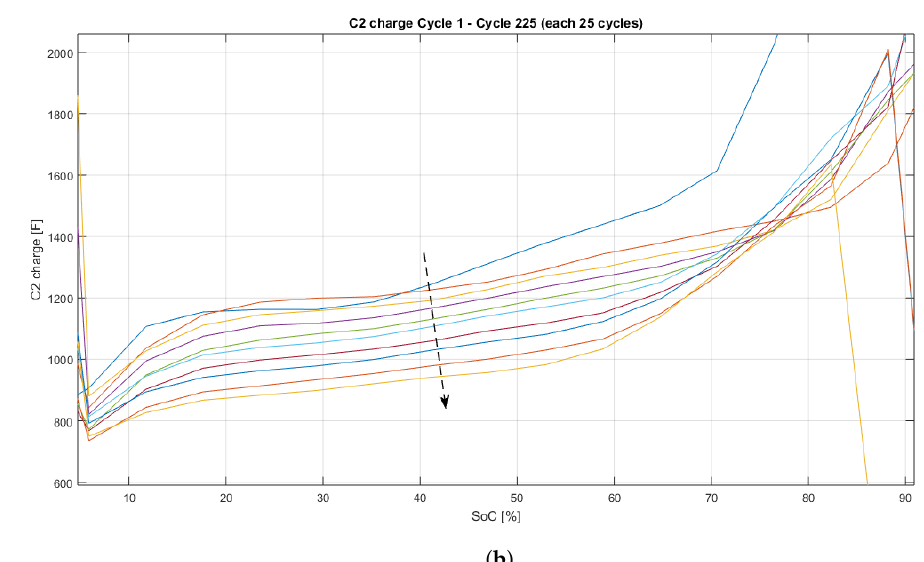
Figure 4. Parametric evolution of ( a ) R 0 during discharge and ( b ) C 2 during charge. Each colored line show results after every 25